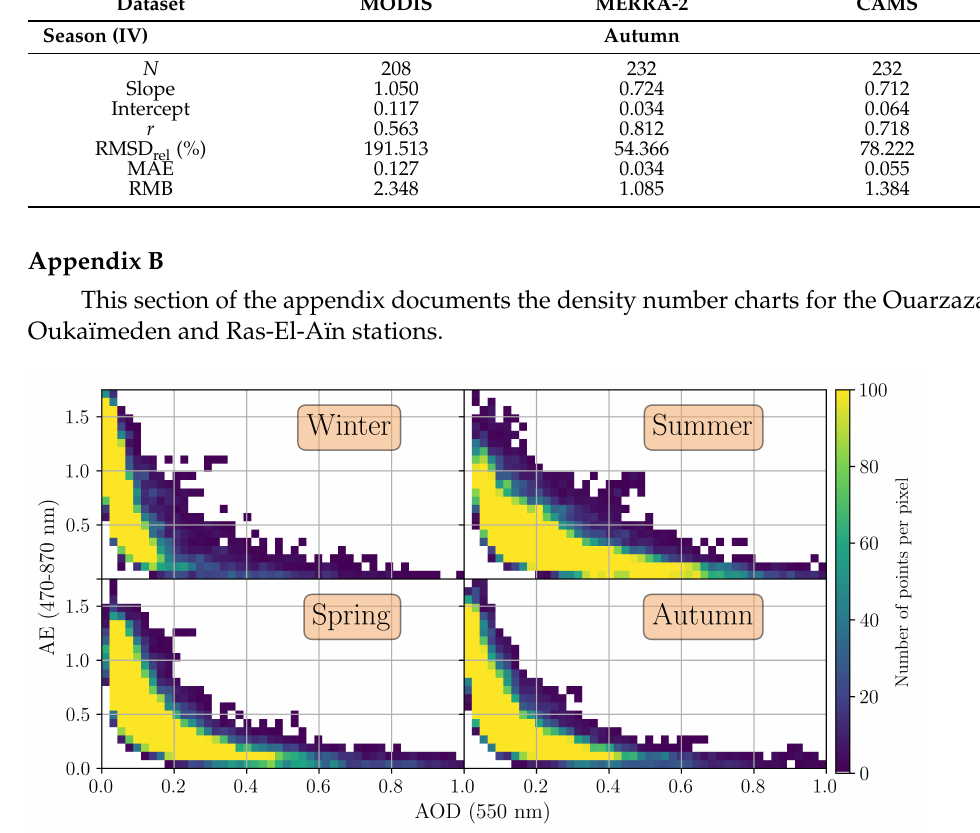
Figure A1. Density number plot between MERRA-2 AOD and AE (2002–2020) per season over Ouarzazate.